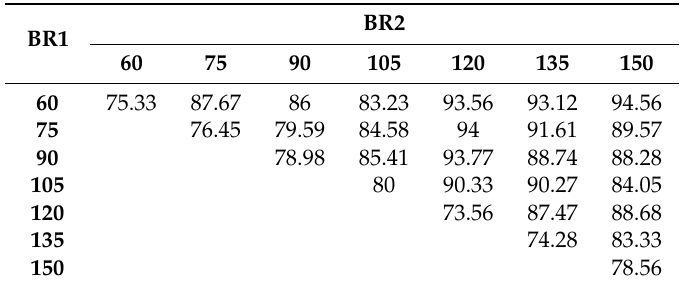
Table 13. Feature fusion Detection Accuracy—NeroAAC-FAAC